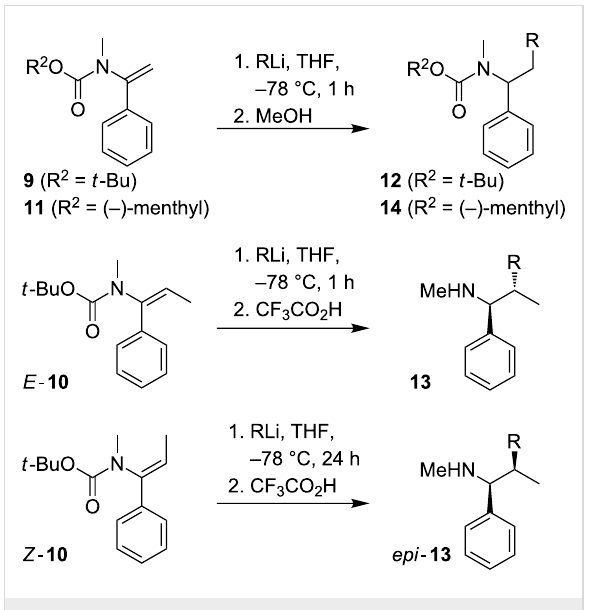
assume, by analogy with the reactions of the equivalent ureas, to be that shown, arising from syn -carbolithiation and retentive protonation.